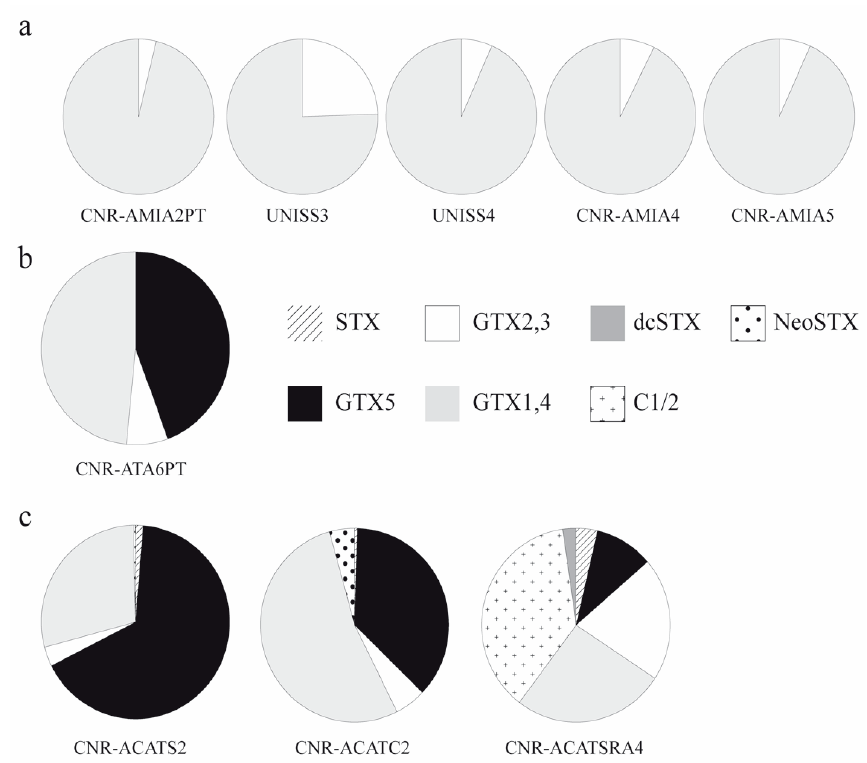
Figure 4. Percentage composition of PST toxins in the analysed strains. a = Alexandrium minutum strains; b = A. tamarense strain; c = A. pacificum strains.